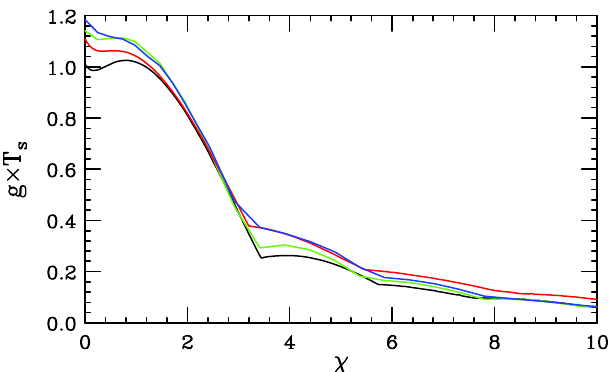
FIG. 23. The growth factor g × T as a function of χ at ϒ ¼ 2 . FIG. 24. The growth factor g × T as a function of χ at ϒ ¼ 1 . 5 . s s The black line is the MOSCOW result, while the green line is the The black line is the MOSCOW result, while the green line is the simulation result, for the trapezoidal wake model. The red line is simulation result, for the trapezoidal wake model. The red line is the MOSCOW result for the LEP broadband resonator model at the the MOSCOW result for the LEP broadband resonator model at the bunch length of 2 cm and at the bunch current of 0.78 mA that bunch length of 2 cm and at the bunch current of 0.585 mA that corresponds to ϒ ¼ 2 . The blue line is the simulation result for corresponds to ϒ ¼ 1 . 5 . The blue line is the simulation result for the LEP broadband resonator model. the LEP broadband